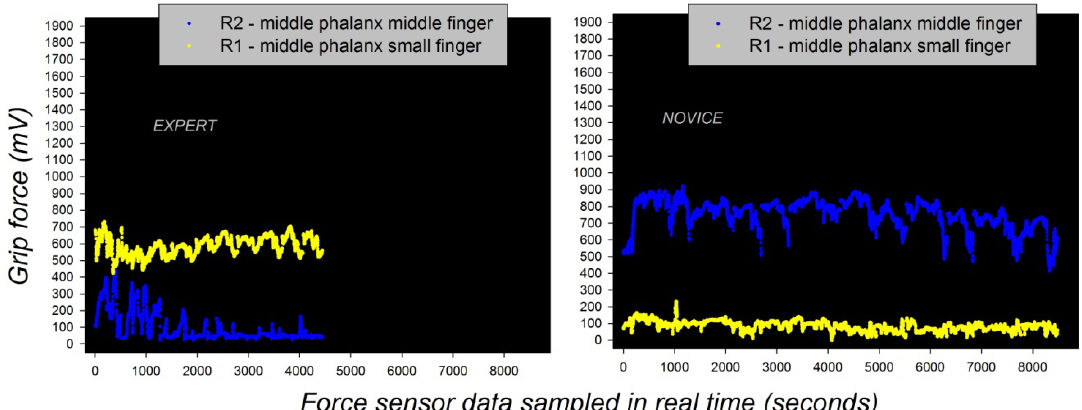
Figure 4. Individual grip force profiles of an expert (left) and a beginner (right) in a robotic task [103,104] reflecting two radically different functional states with respect to gross (middle finger) and fine (small finger) grip force control, translating motor expertise and functionally reorganized somatosensory network states (cf. Figure 3), governed by self-organization.